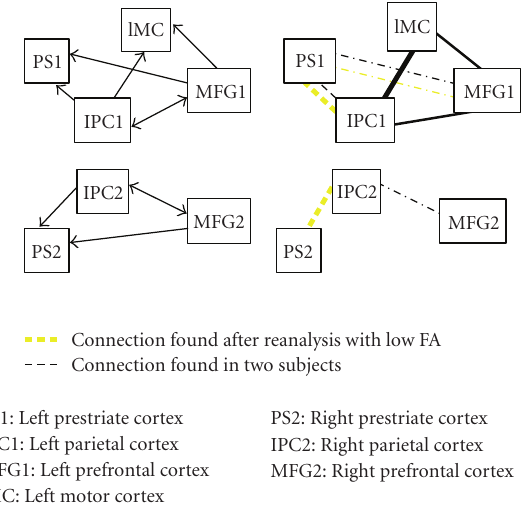
Figure 6: The network and results for Rowe et al.